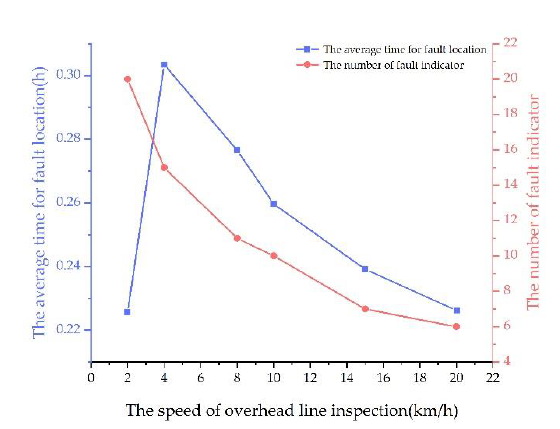
Figure 8. The number of fault indicators and the average time for fault location under different speeds.